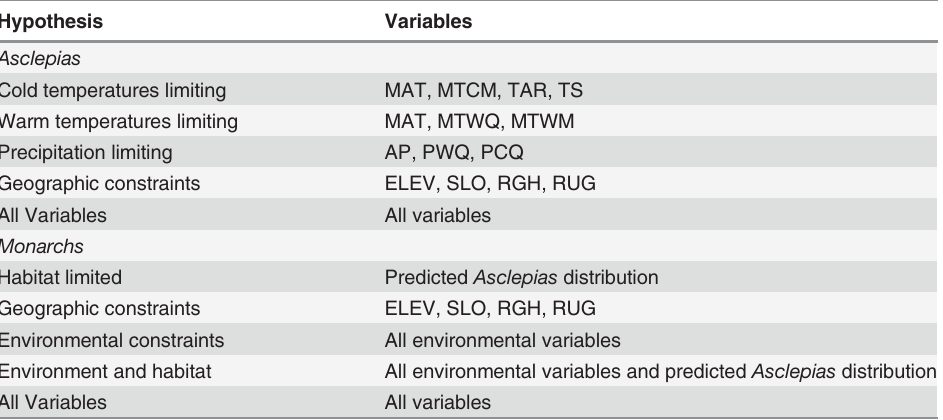
Table 1. List of hypotheses for both Asclepias and monarchs, along with relevant predictor variables.